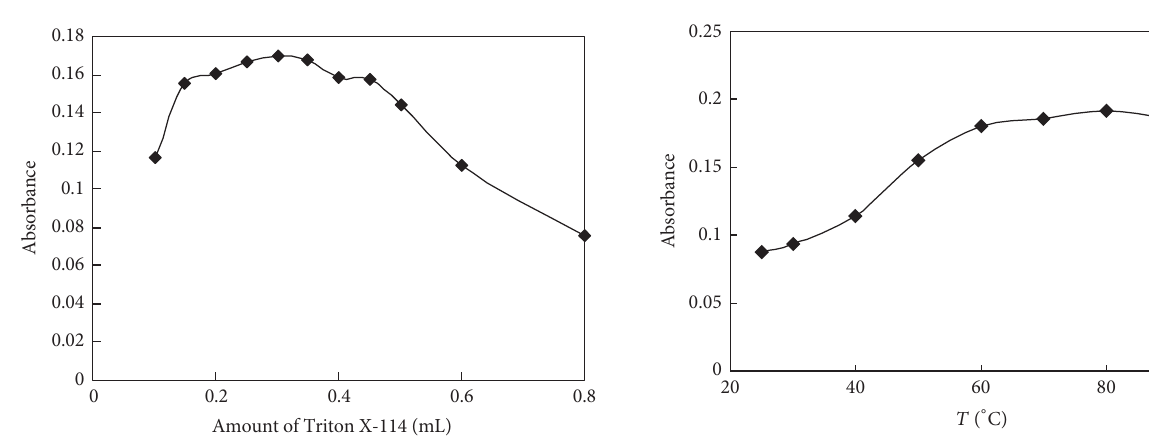
C, centrifugation for 5min at ∘